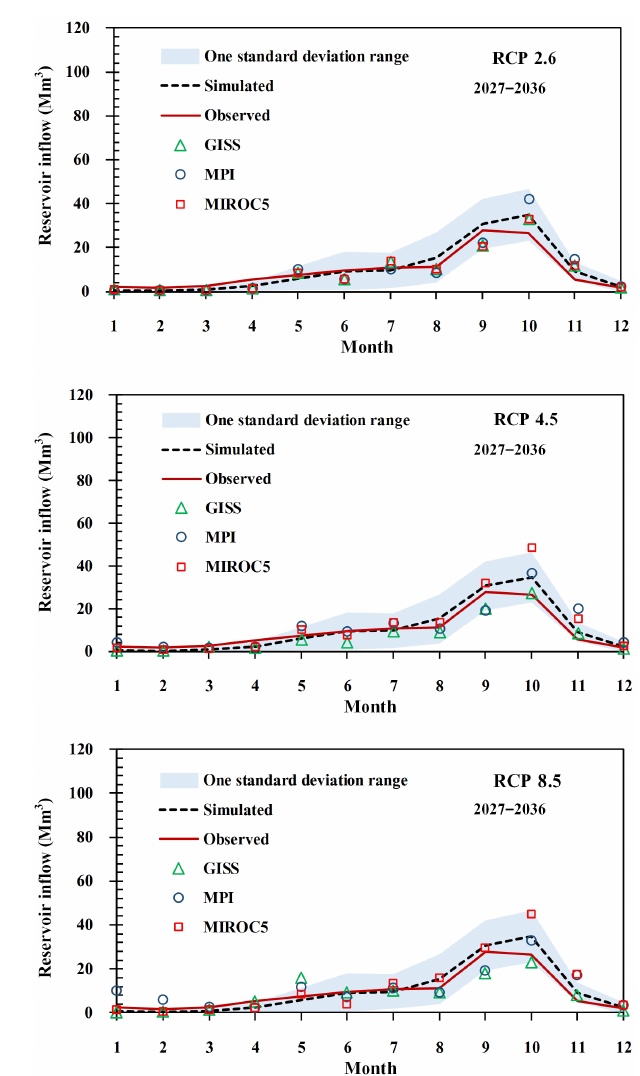
Figure 13. Projected mean monthly reservoir inflows under 3 sce- narios for the years 2027–2036 at Klong Yai